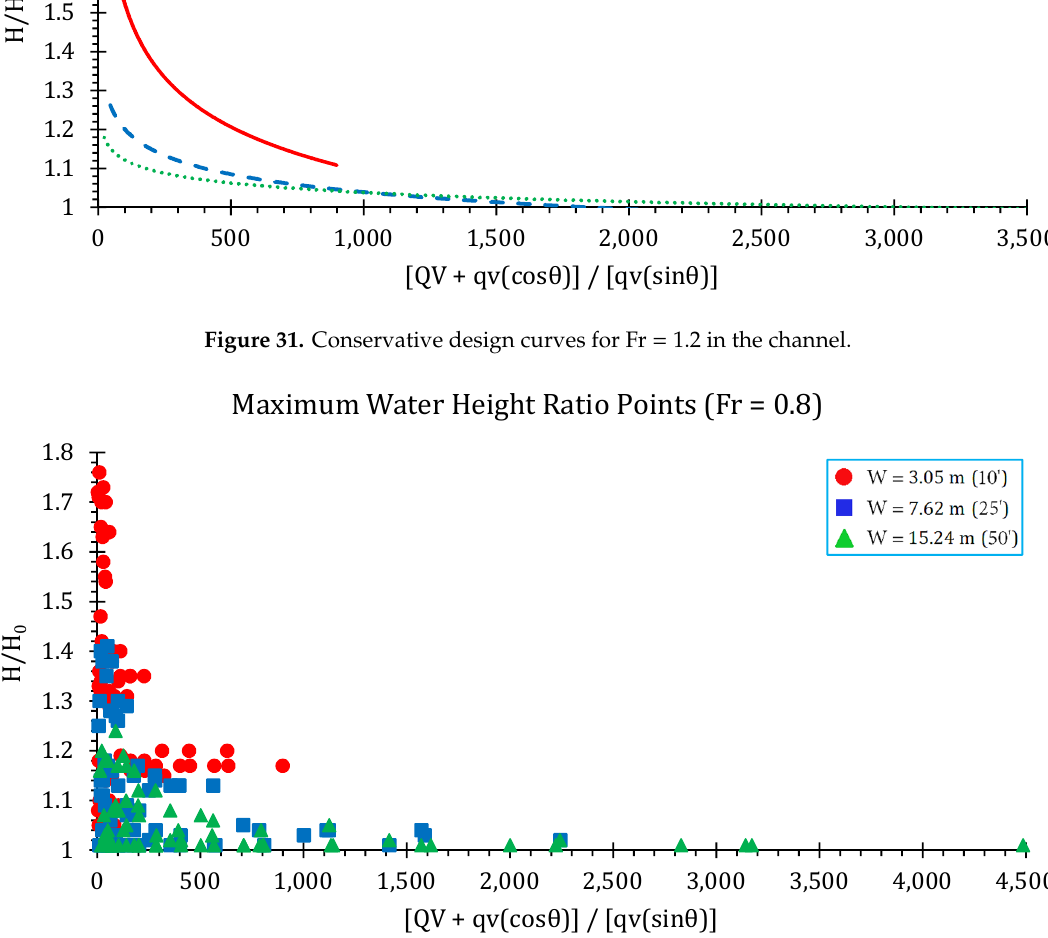
Figure 32. Simulation results for Fr = 0.8 in the channel.